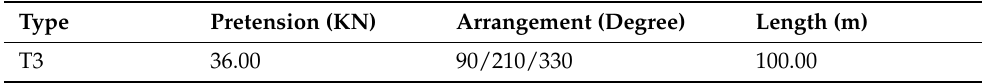
Figure 4. Foundation with its three-point taut mooring system (T3). ( a ) 3D view, ( b ) top view. Table 2. Properties of mooring